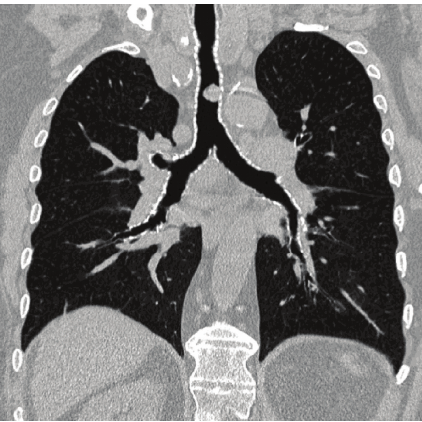
Figure 2: CT scan. CT coronal reformation shows the longitudinal extent of the tumor, its location 35mm above the carina, and the severity of tracheal narrowing (40%).